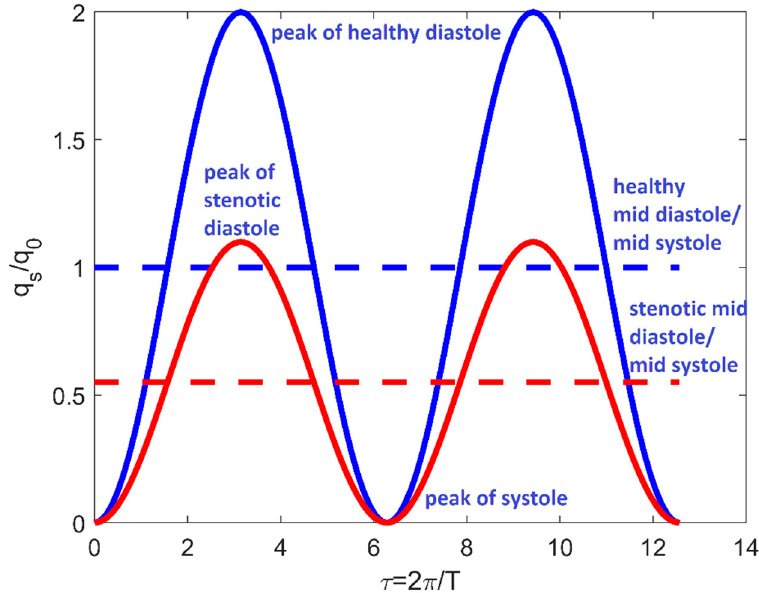
Figure 3. Time-dependent boundary condition in system (16) for ξ = 0.55 and t 0 = 0. Red lines refer to − Θ s /2 ≤ θ < Θ s /2; blue lines refer to Θ s /2 ≤ θ < 2 π − Θ s /2. Full lines are referred to the periodic inflow rate; dotted lines indicate the mid-diastole/mid-systole value.